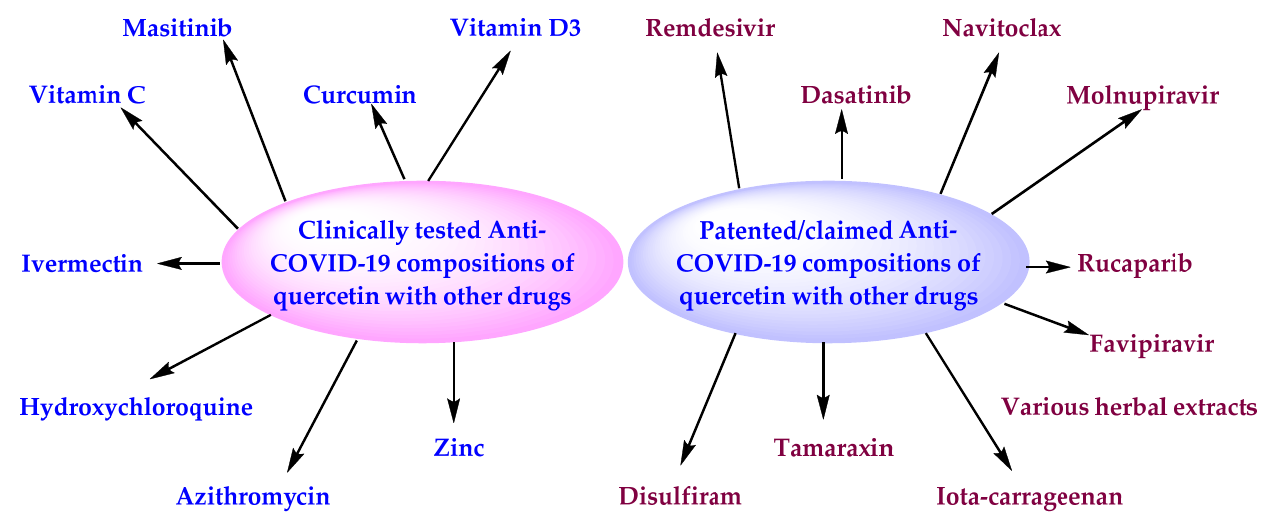
Figure 5. Important anti-COVID-19 combinations of quercetin [44–96], Table